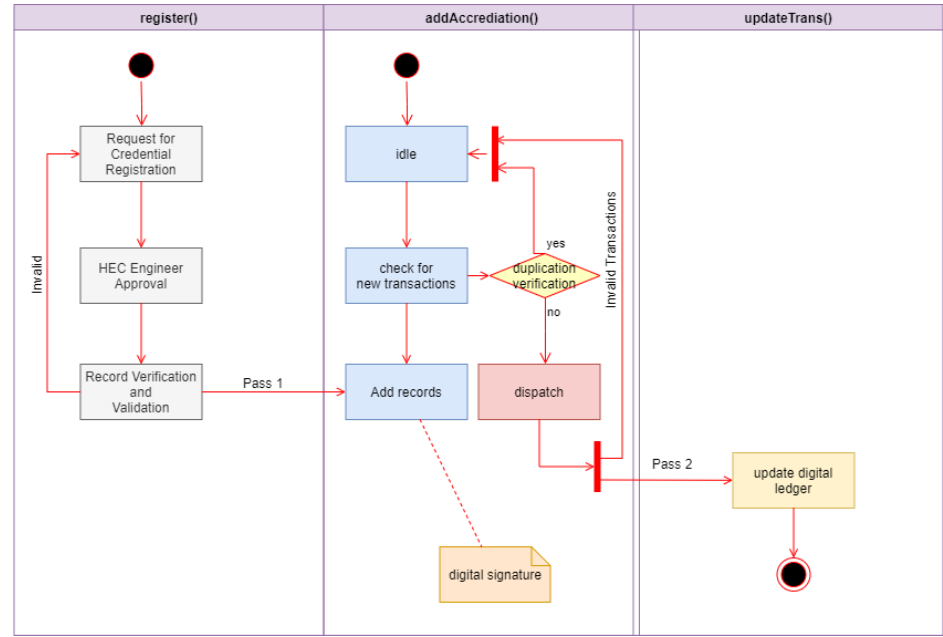
Figure 5. Event of nodes transactions execution through activity diagram. Table 3. List of events of nodes transactions and execution of proposed HEC degree attestation traceability architecture. Series of Events Working Description